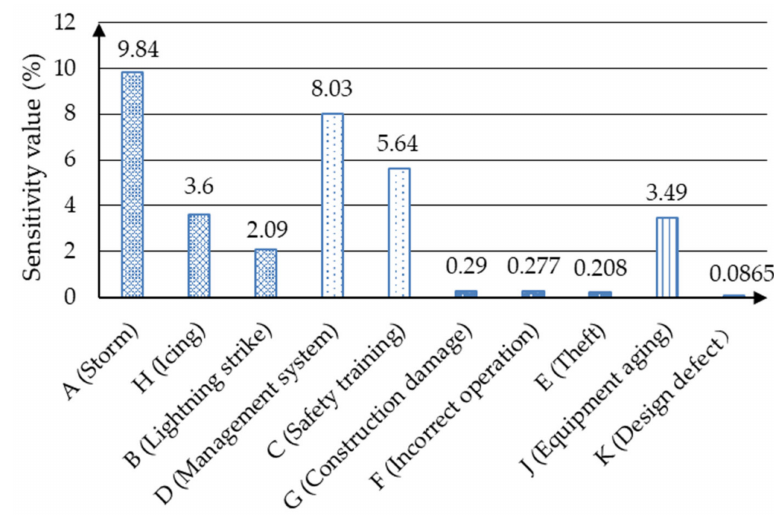
Figure 13. Sensitivity of the root of “Environmental causes”, “Improper management”, “Human causes” and “Equipment failure”.